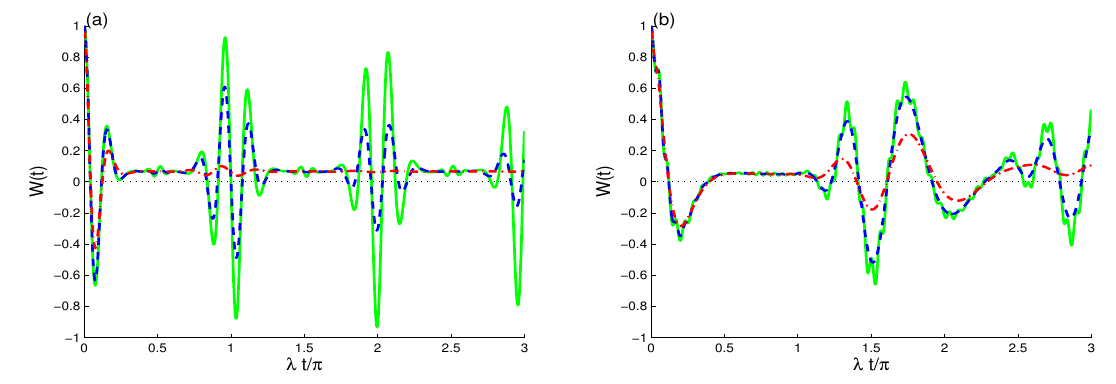
Figure 1. The atomic inversion for k = 1 and α = 5 with different decoherence values of γ : γ / λ = 0 4 (green solid curves), γ / λ = 0.001 (blue dashed curves), and γ / λ = 0.01 (red dashed dot curves) with J / λ = 0 in ( a ) and J / λ = 30 in ( b ).